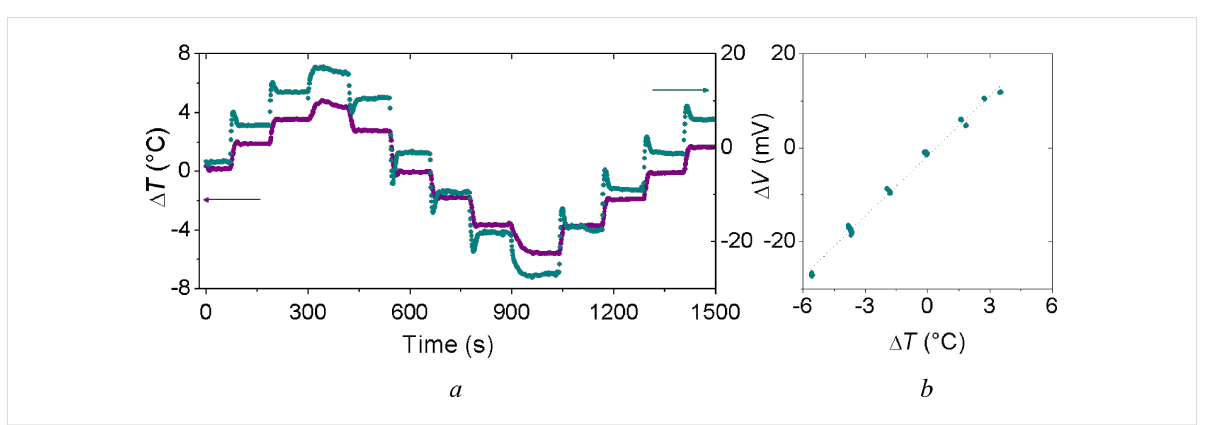
Figure 6: (a) Dependence of the applied temperature difference Δ T and the thermoelectric voltage Δ V as function of time and (b) the generated voltage Δ V versus the applied temperature difference Δ T for the planar thermoelectric device.